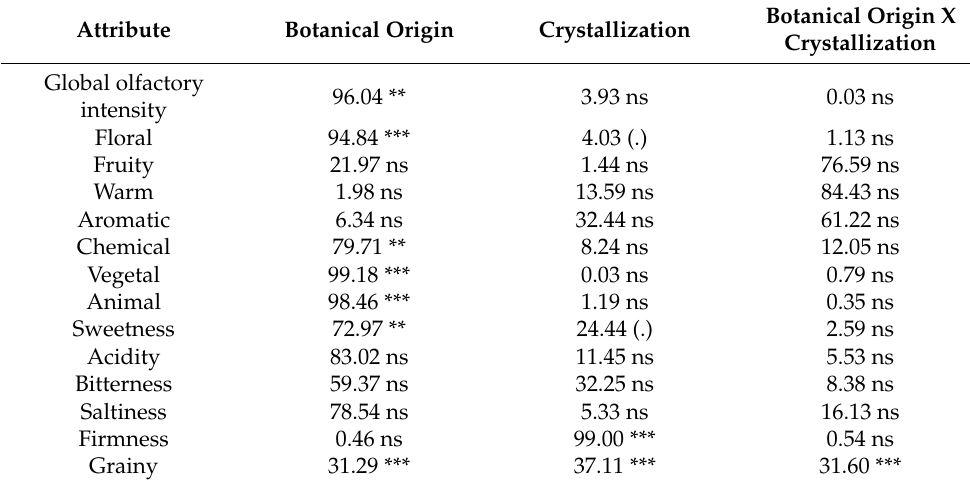
Table 5. ANOVA factorial design. Variability is expressed as % of the total sum of the squares for sensory attributes.